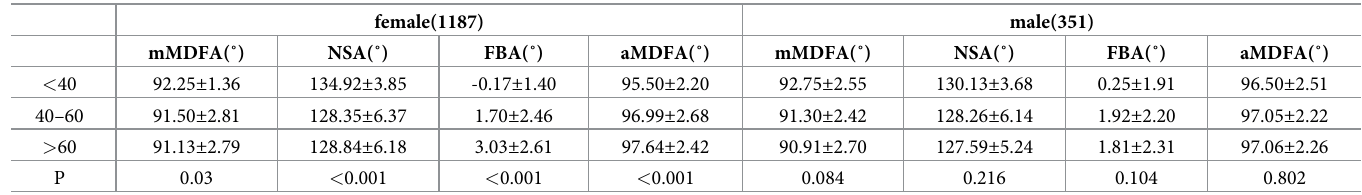
Table 3. Mean values of groups.